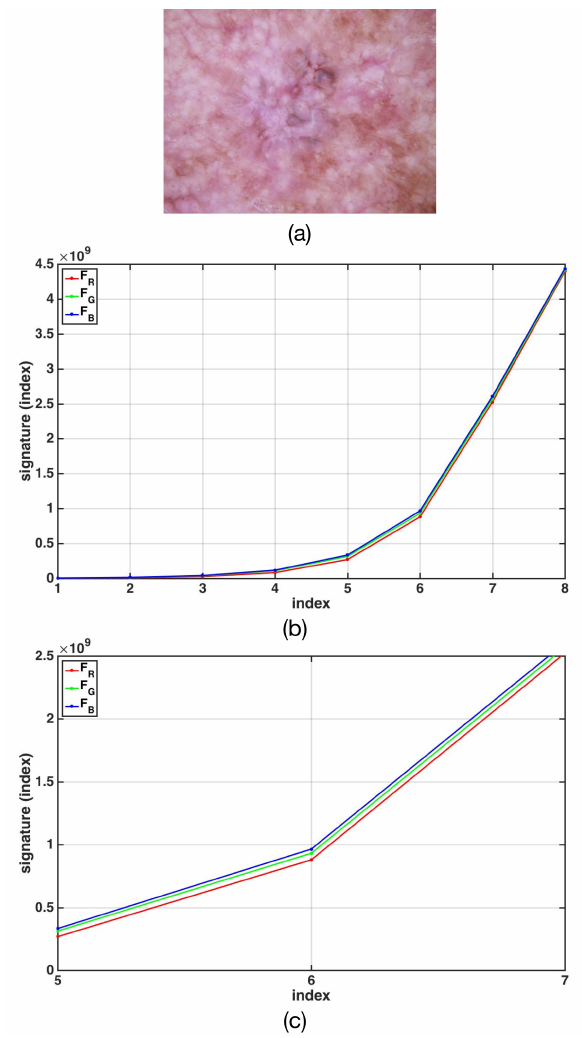
Figure 2. Fractal signature examples. ( a ) Color image of actinic keratosis. ( b ) F R , F G , F B fractal signatures from channel red, green, and blue, respectively. ( c ) Amplification region of the signatures’ graphs to see the difference in the values of the three